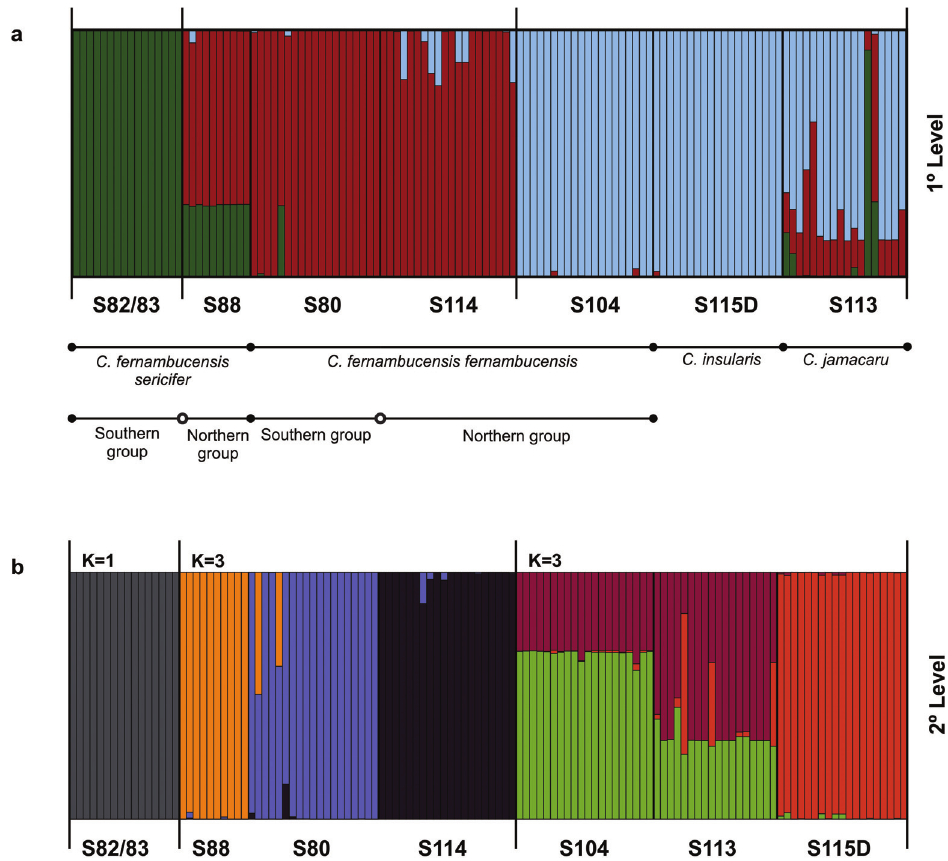
Figure 1 - Population differentiation in STRUCTURE, (a) results for K = 3 on the first level structure, and (b) separating each population as a distinct ge- netic group. The southern and northern population groups of C . fernambucensis subsp. sericifer and C. fernambucensis subsp. fernambucensis are based on phylogeographic circumscription (Franco et al. , 2017b).